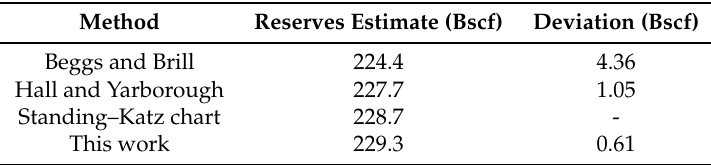
Table 4. Reserves’ prediction by various methods (Case Study